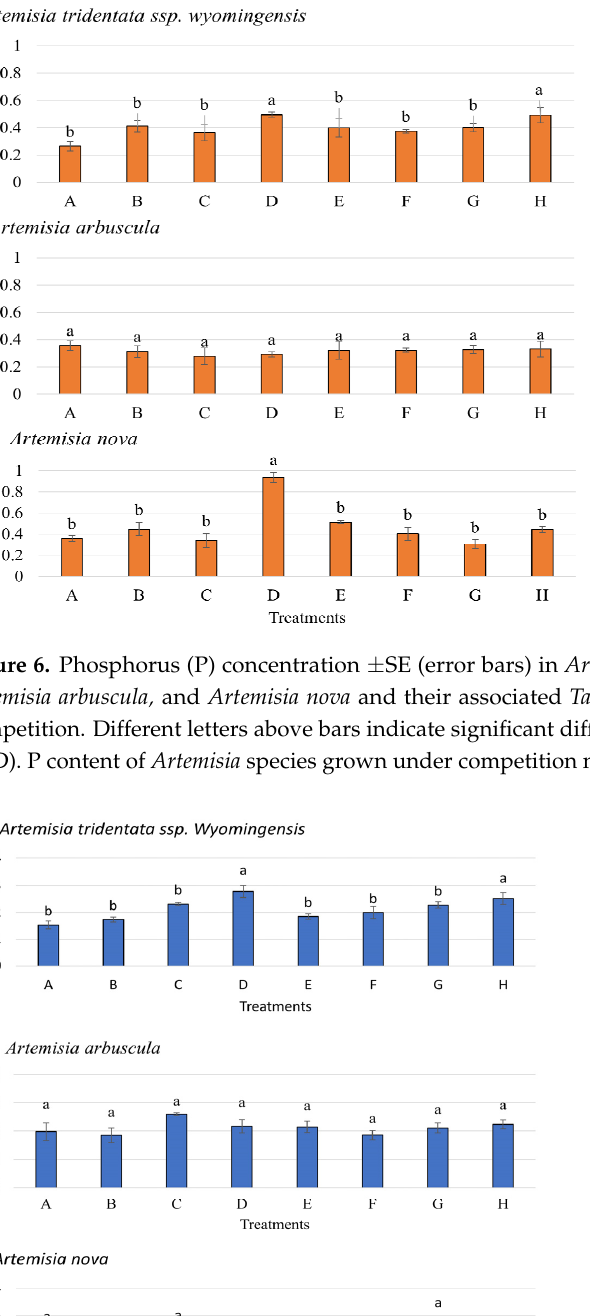
Figure 5. Nitrogen (N) concentration ±SE (error bars) in Artemisia tridentata ssp. wyomingensis , Arte- misia arbuscula, and Artemisia nova . Different letters above bars indicate significant differences among treatments (Tukey’s HSD). N content of Artemisia species grown under competition not measured.